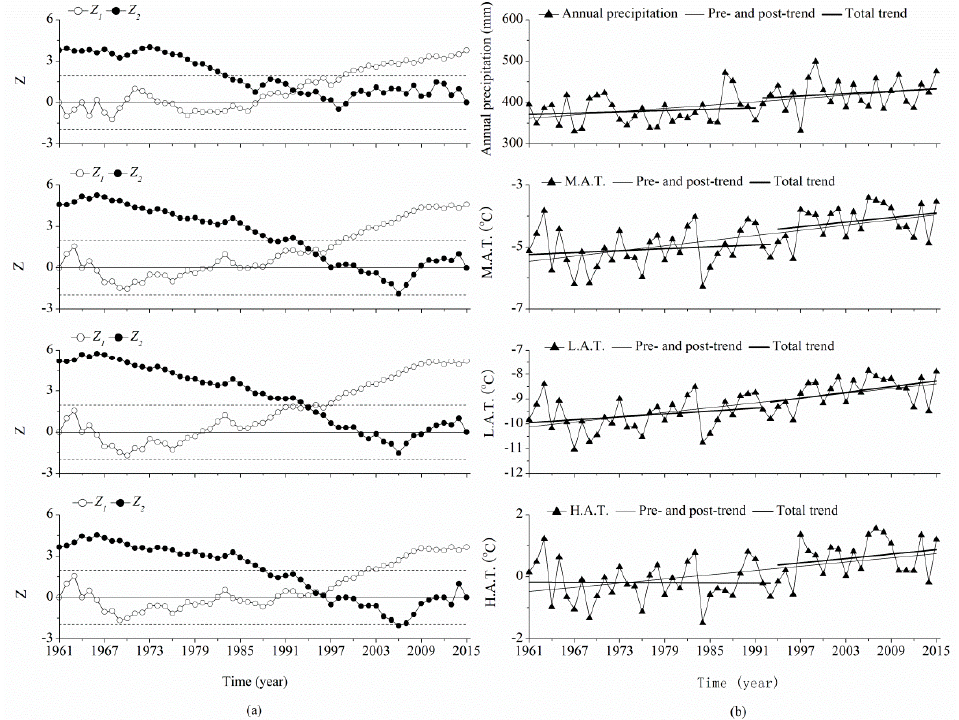
Figure 3. Nonparametric MK test and liner regression analysis of ( a ) annual precipitation and ( b ) temperature (mean annual temperature (MAT), lowest annual temperature (LAT), and highest annual temperature (HAT)).